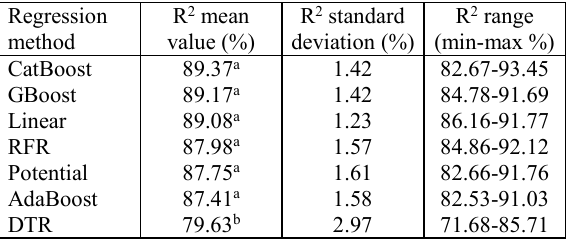
Table 3 . Statistics of R 2 for multivariate allometric models DBH = Φ(H, CD). Mean values with different superscript letters are significantly different (p<0.05) (two-sample t-test).